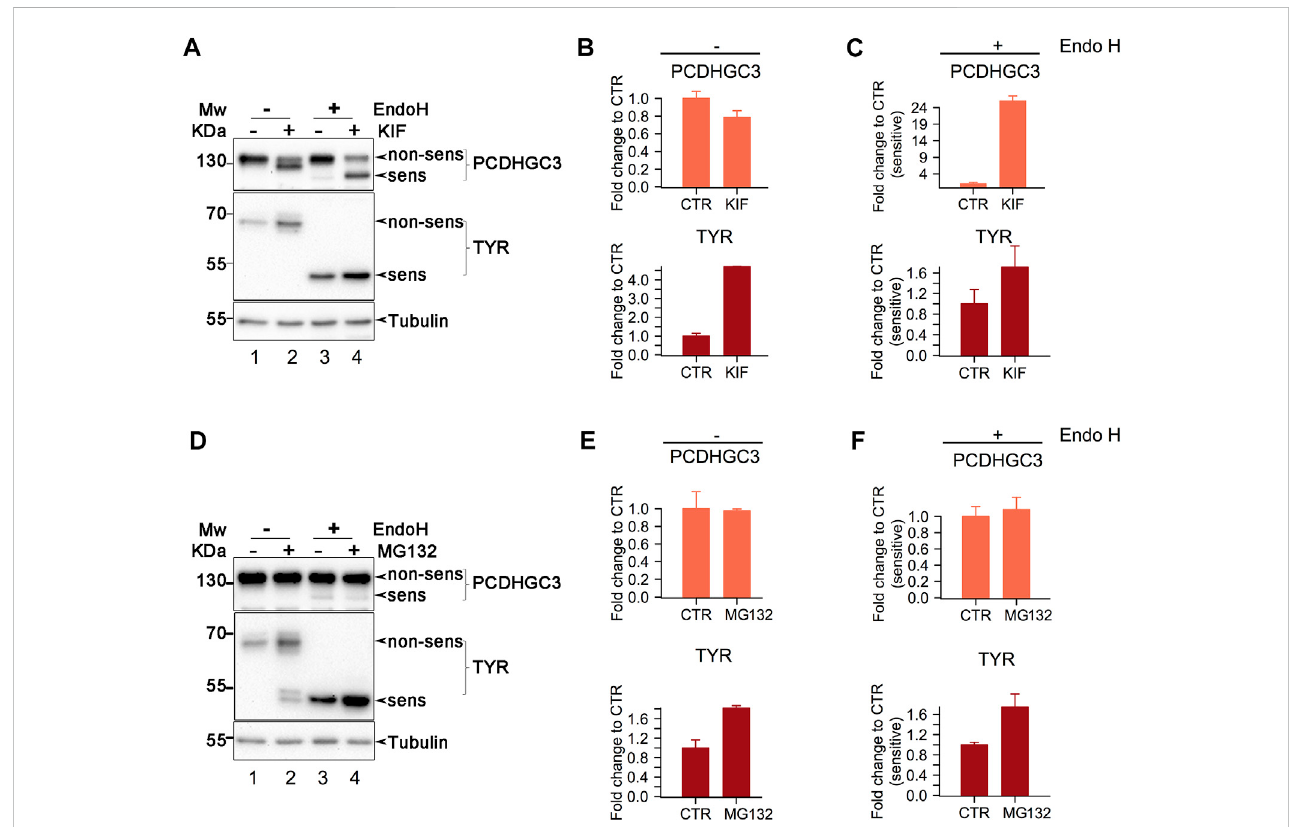
FIGURE 5 WesternBlotanalysisofclassImannosidasecandidatesubstrates. (A). AnalysisofcellstreatedwithKIF.Celllysatesweresplit,andonepartwassubjectto Endo H digestion. Proteins were then separated in polyacrylamide gels and transferred on nitrocellulose membrane which were further incubated with the designated antibodies. Shown is a representative experiment of duplicates samples. (B, C). Samples in A were subject to densitometry analysis and the obtainedvalueswerefurtherusedtoassessthedifferencesbetweentheconditions.BarsaremeansofduplicateexperimentsanderrorbarsareSEM. (D). Similar as in (A)., but the cells were treated with MG132, proteasome inhibitor. (E, F). Densitometry analysis of samples from (D). Bars are mean of triplicate experiments and error bars are